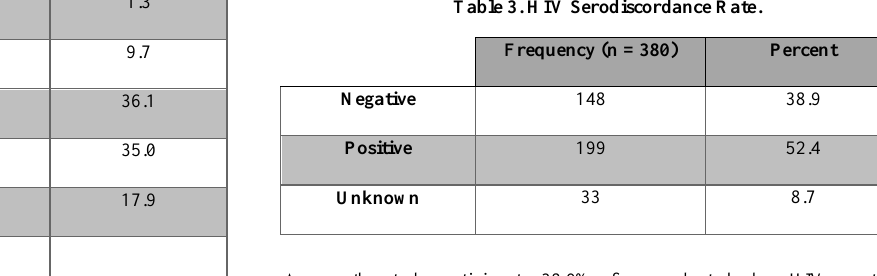
Among the study participants, 38.9% of respondents had an HIV-negative partner, reflecting the serodiscordance